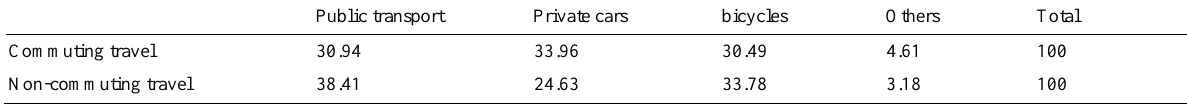
Table 7: Travel modes for commuting and non-commuting travel in Beijing(2005) （ % ）